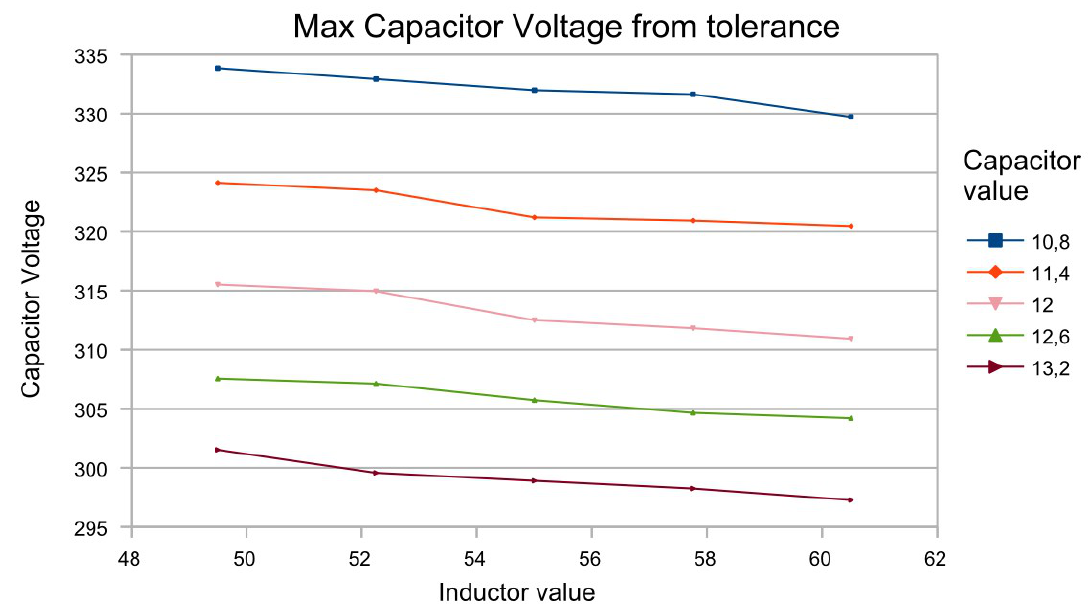
Figure 7. Tolerance analysis of the maximum capacitor voltage.